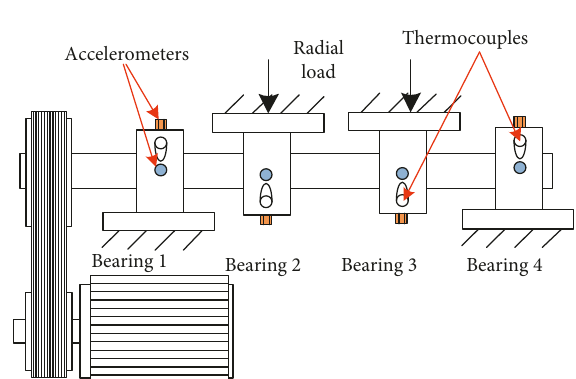
Figure 7: The kurtosis variation of bearing 1 during the